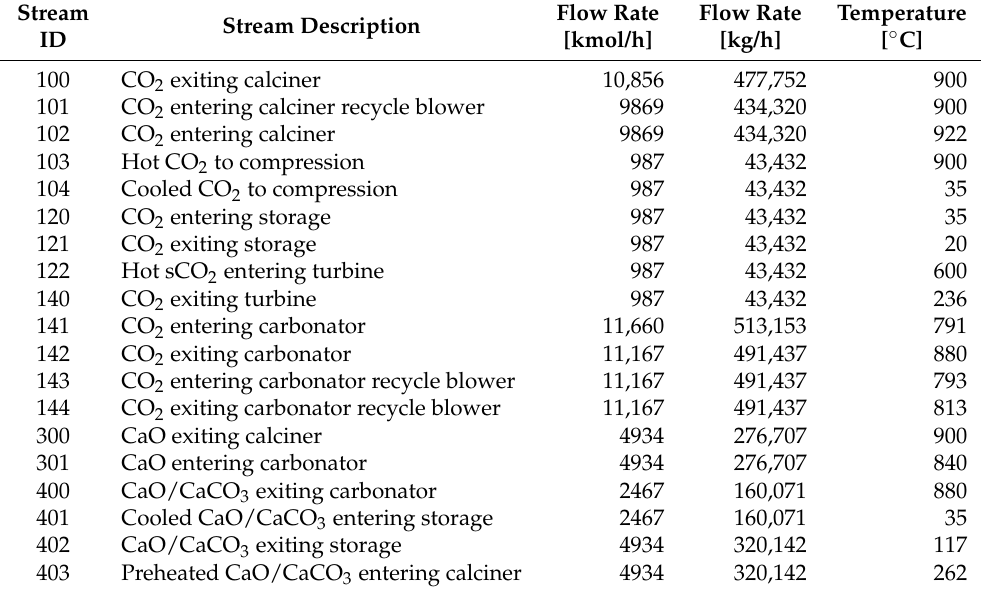
Table A1. Configuration 1 base case material stream summary.